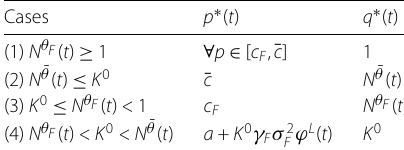
Table 2 The optimal premium and reinsurance strategies